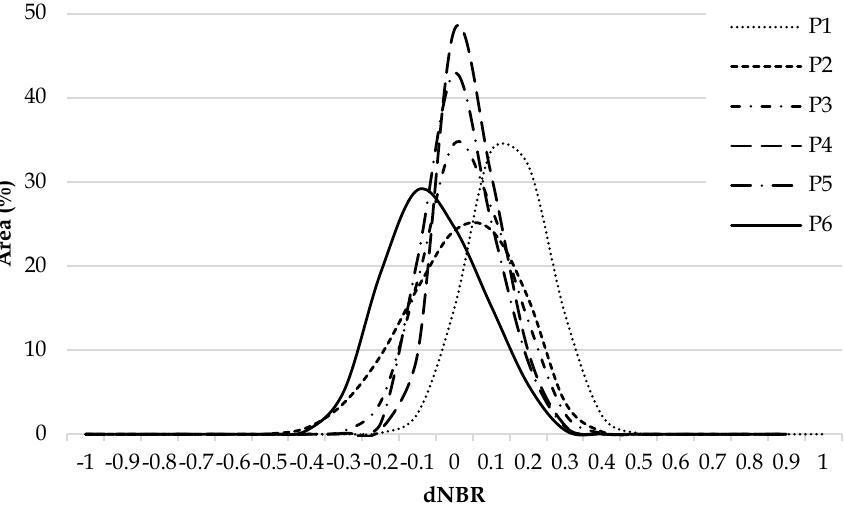
Figure 6. Distribution of dNBR product of different periods ( P ).